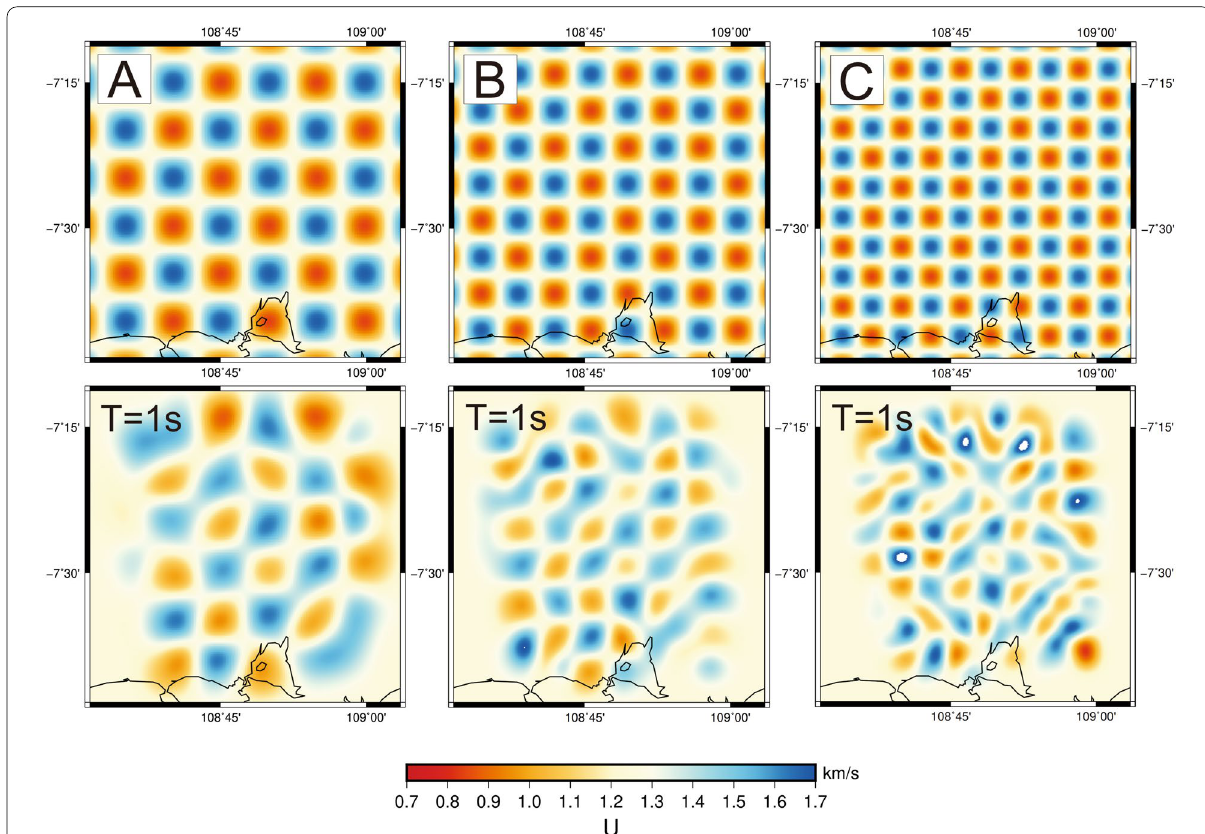
Fig. 3 A–C Synthetic Rayleigh wave group velocity models for each cell grid size, ranging between ~ 8.5 km and ~ 5.5 km 5.5 km; and the final model obtained after applying the checkerboard resolution test for period 1 s of the synthetic model, showing × the distribution of stations in the study